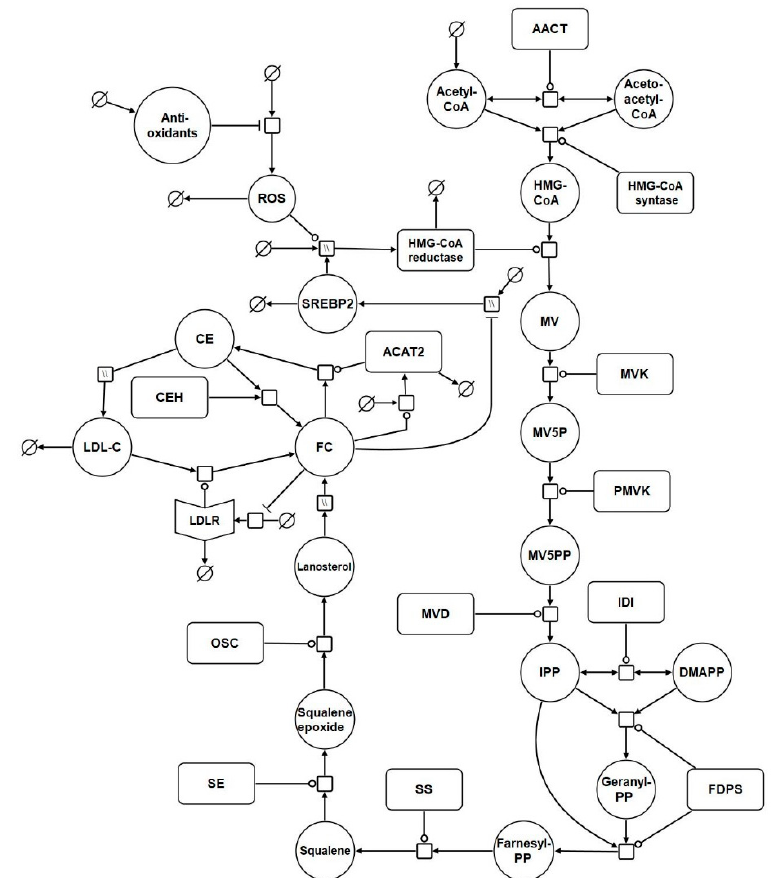
Figure 1. Network diagram of the model. The systems biology graphical notation network (SBGN) diagram comprises of key elements of the cholesterol biosynthesis pathway, and includes reactions which represent the synthesis, degradation, and regulation of hepatic LDL receptors (LDLrs). Finally, it incorporates reactions which depict the effects of aging on cholesterol homeostasis. Round arrow heads represent the target of a catalytic enzyme. Arrows represent flux. The mathematical symbol for an empty set represents a synthesis or sink reaction. All of these reactions are described in detail in the main body of the text. Hatched process nodes represent omitted processes.